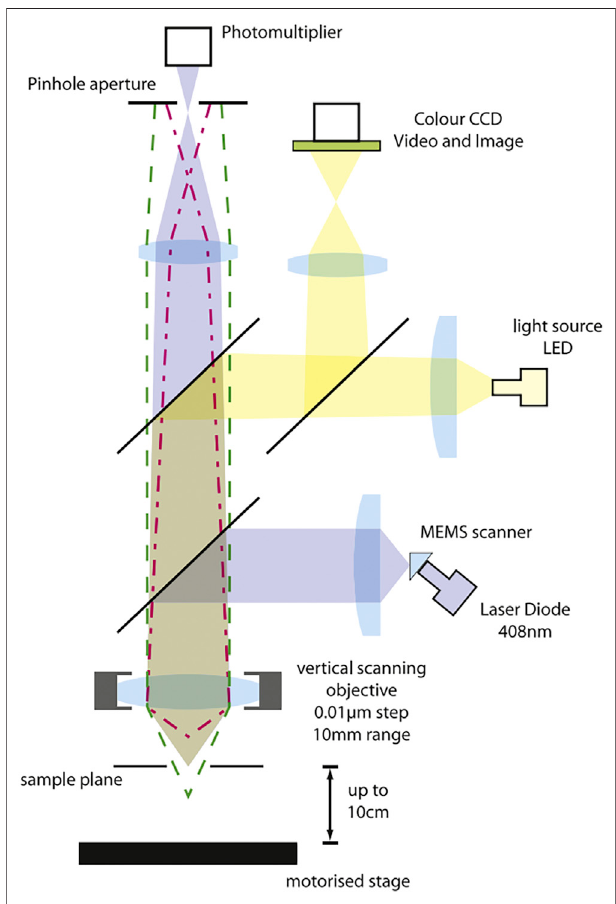
FIGURE 4 | Principle diagram of laser confocal scanning microscope (Evans and Donahue,